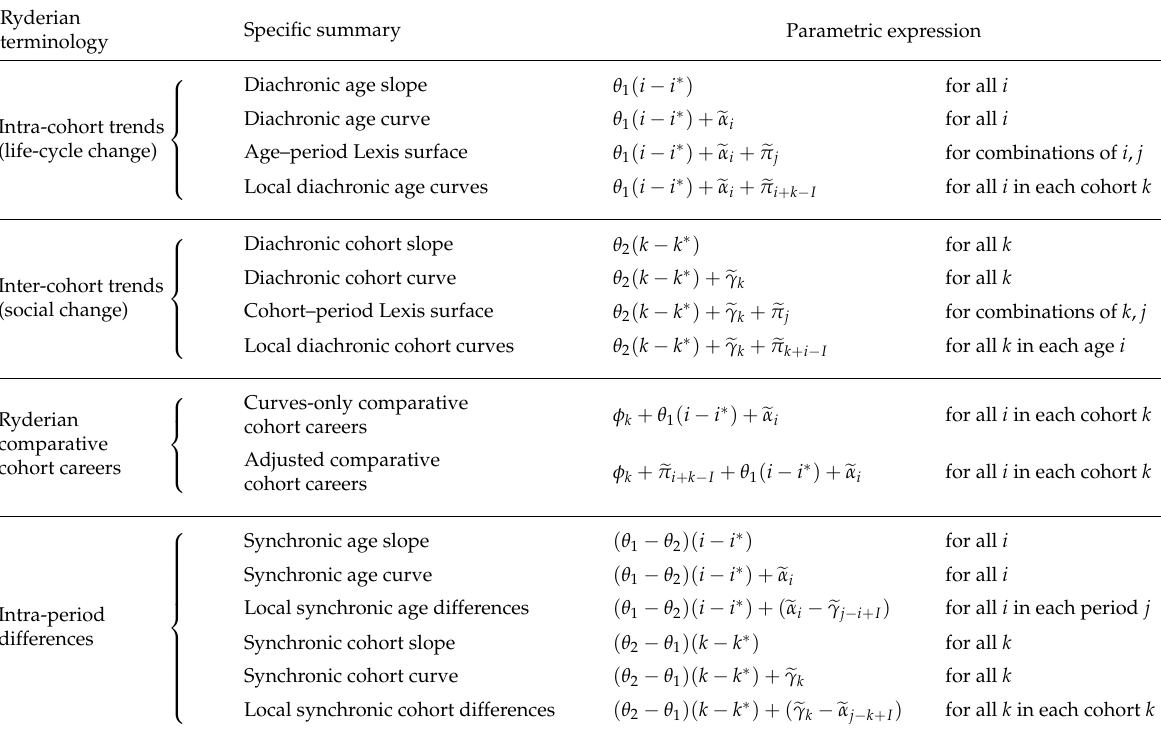
Table 5: Summarizing population-level temporal variability with an APC model Ryderian Specific summary Parametric terminology